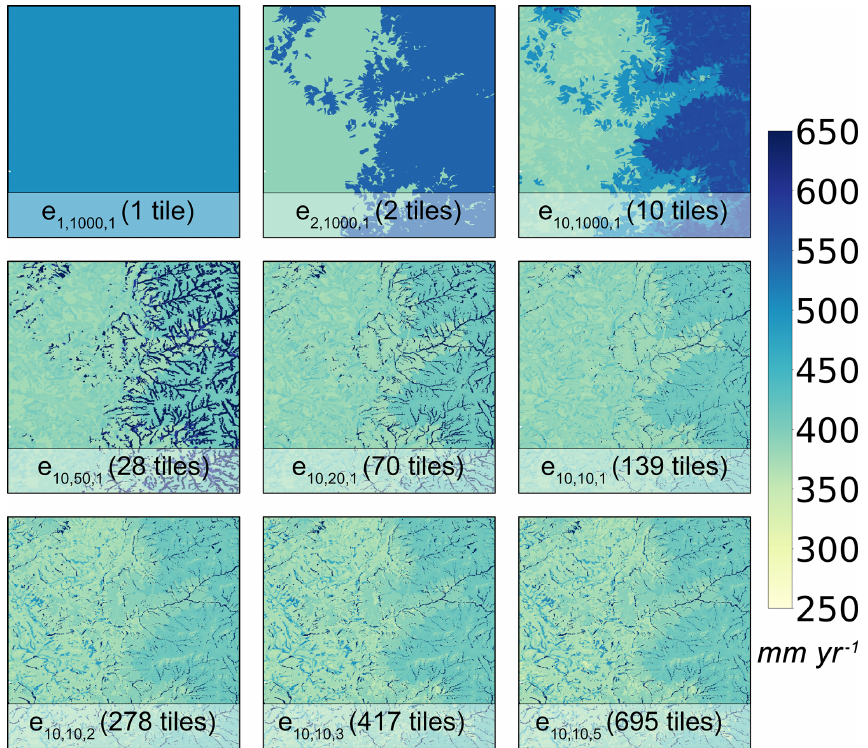
Figure 8. Visual comparison of the mapped annual mean (2002–2014) of simulated evapotranspiration for the nine model experiments in Table